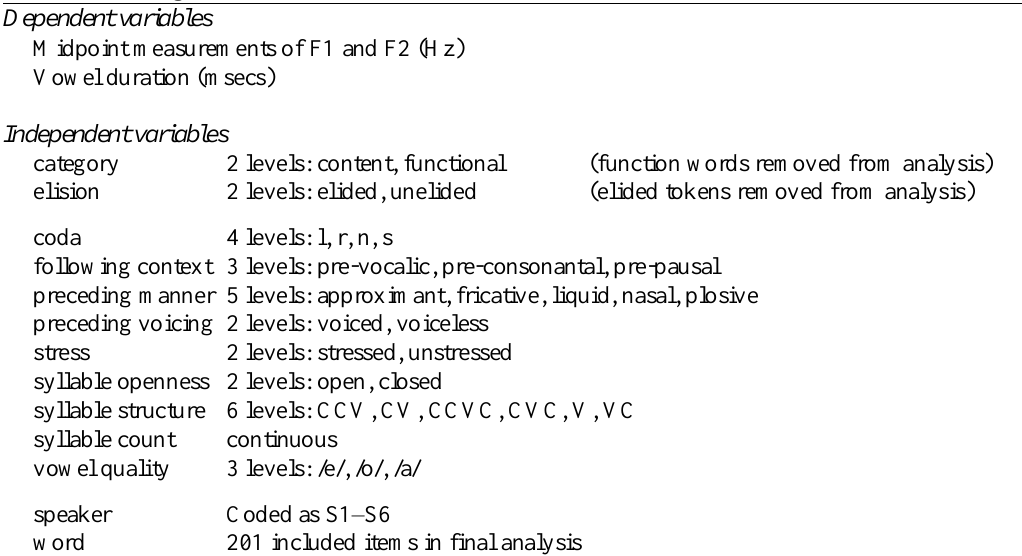
Table 1. Coding of